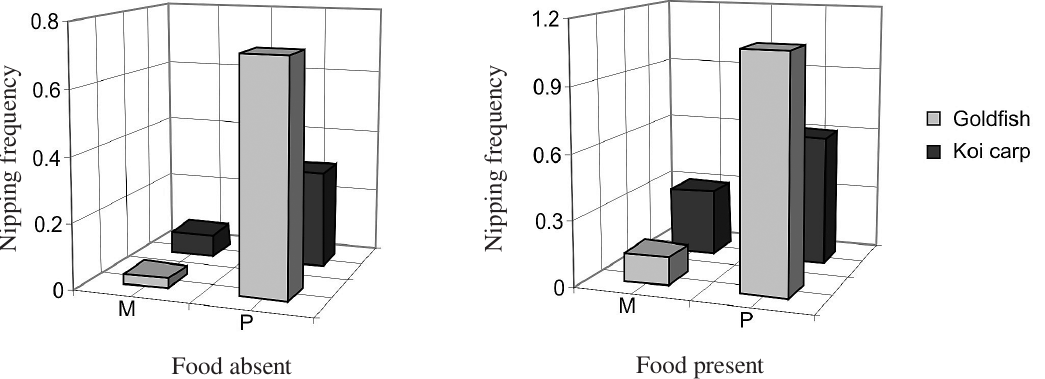
Fig. 3. Standardised (per capita) nipping frequency per trial estimated for koi carp and goldfish under monoculture (M) and poly- culture (P) conditions in aquaria in the presence and absence of food (tubifex)